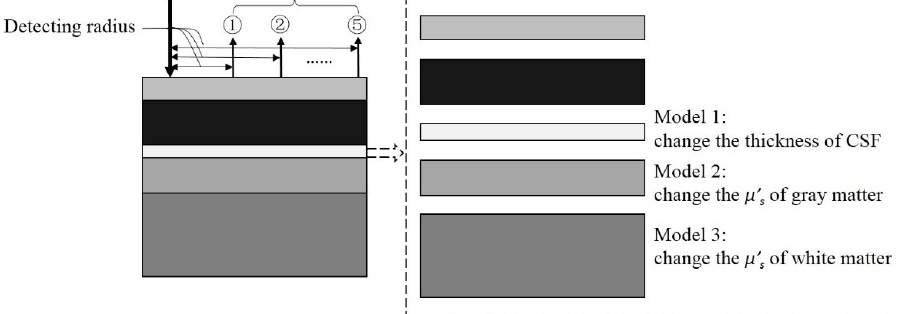
values of each layer were cali- each phantom, (cid:1) 0 s brated by the ISS oximeter (96208, ISS, Cham- paign, IL). Figure 4 shows the process of